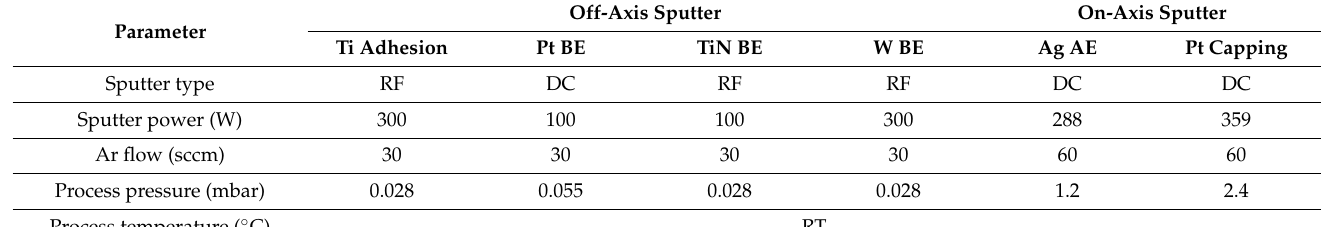
Table A1. Sputter parameters for the bottom and top metal layer fabrications.